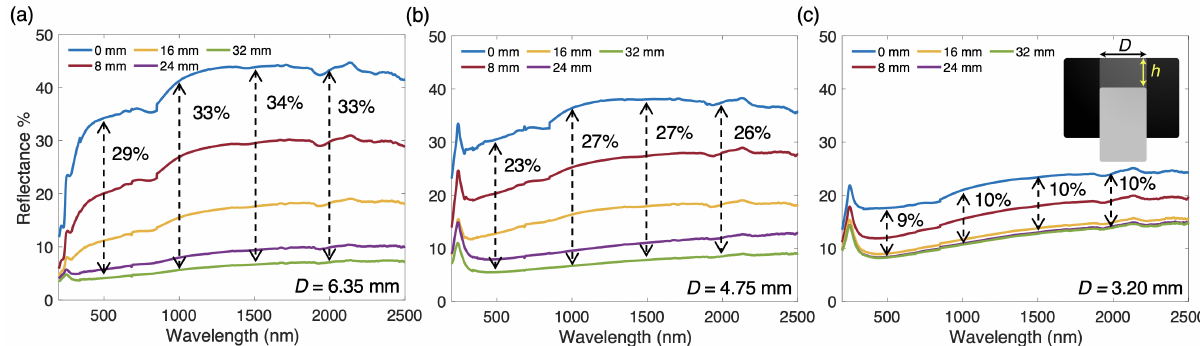
Figure 4. Reflectance spectra of tunable piston structures with variable piston displacement h , as indicated by the inset schematic. Piston diameters D are ( a ) 6.35 mm, ( b ) 4.75 mm, and ( c ) 3.20 mm.